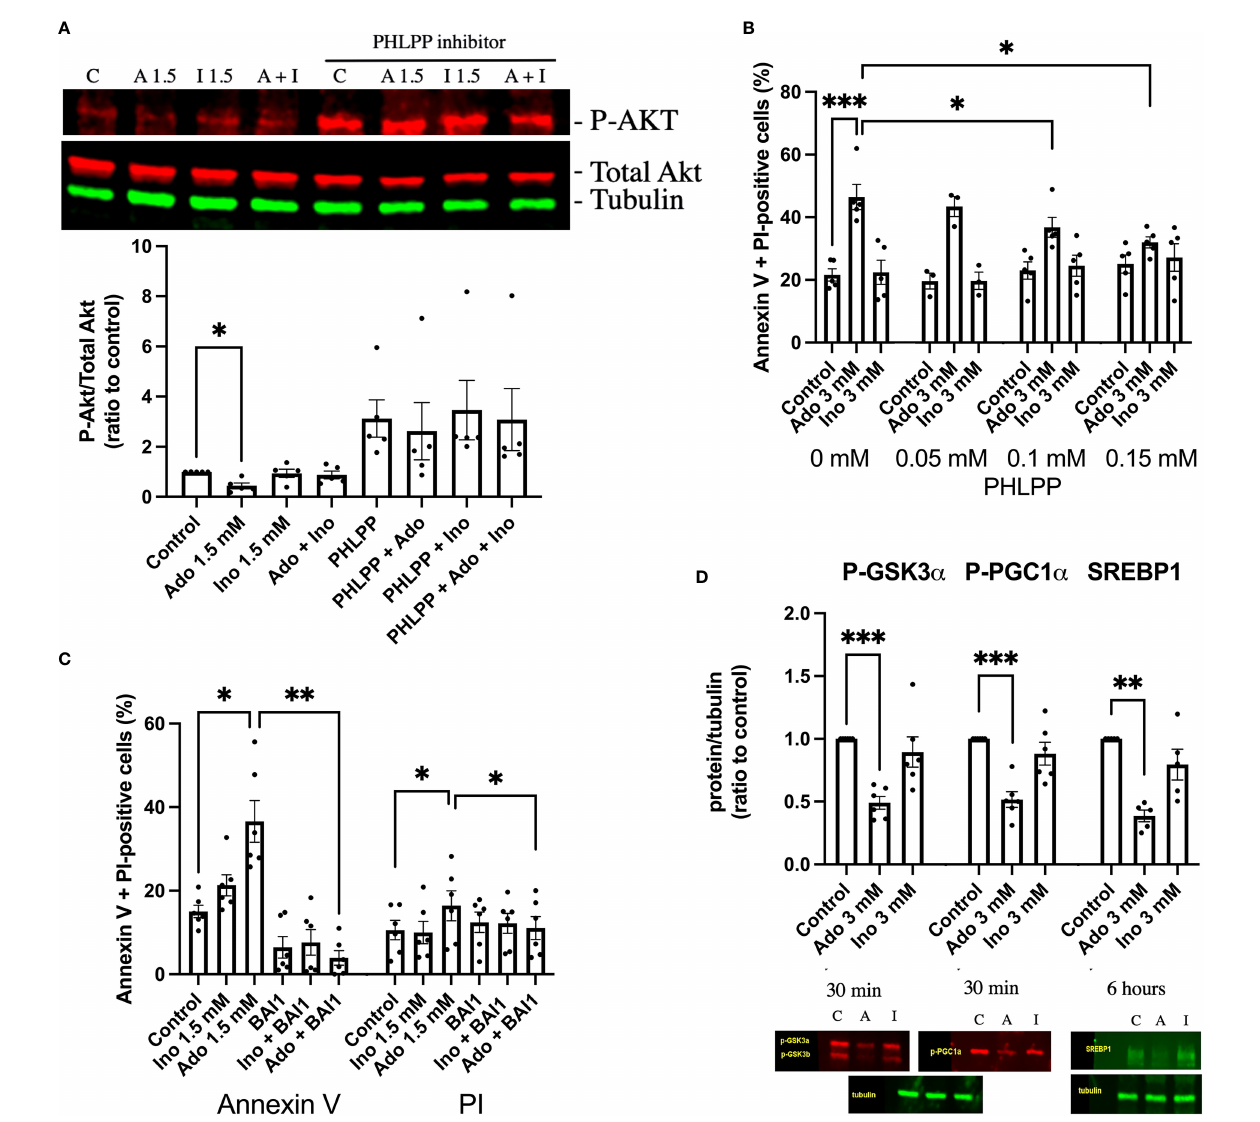
FIGURE 3 Adenosine-induced inhibition of Akt leads to increased beta-cell death. (A) EndoC-betaH1 cells were incubated for 30 min with 1.5 mM adenosine (A1.5), 1.5 mM inosine (I1.5) with and without 0.15 mM PHLPP inhibitor, and analyzed by immunoblotting for P-Akt. P-Akt signals were normalized to total Akt. (B) EndoC-betaH1 cells were incubated for 18h with 3 mM adenosine or inosine with increasing concentrations of PHLPP inhibitor, and stained with Annexin V and PI for fl ow cytometry analysis of total cell death rates. (C) EndoC-betaH1 cells were incubated for 18h with 1.5 mM of adenosine or inosine, with or without 5 m M of BAI1. (D) EndoC-betaH1 cells were incubated for 30 min or 6h with adenosine or inosine (3 mM) and analyzed by immunoblotting for P-GSK3 a , P-PGC1 a and SERBP1. Phospho-protein signals were normalized to